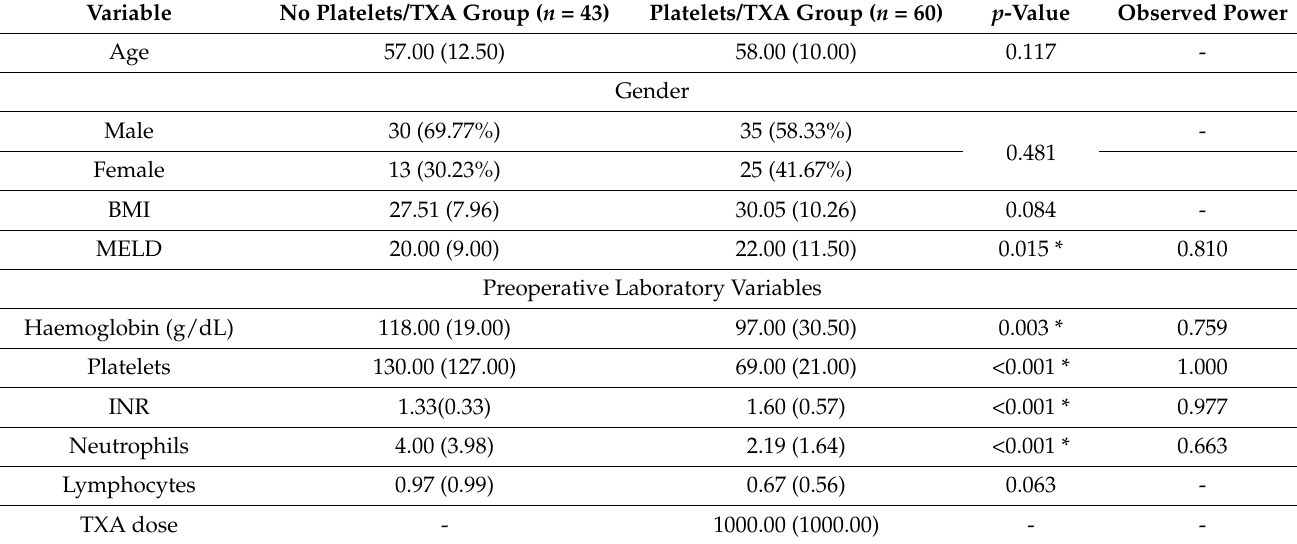
Table 6. Demographics and clinical characteristics of LT patients categorised by combined treatment of platelets and